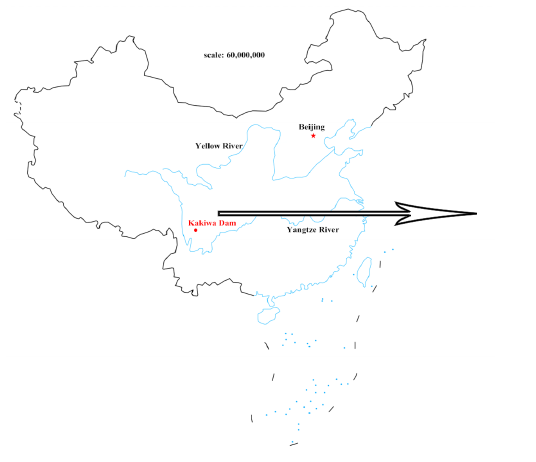
Figure 5. The max cross-section of the dam body. A total of 37 piezometers were installed for seepage monitoring of the dam body and dam foundation. Among them, the piezometer 𝑃 (cid:3005)(cid:3003)(cid:2879)(cid:2869)(cid:2871) is located downstream of the cur- tain. 𝑃 (cid:3005)(cid:3003)(cid:2879)(cid:2870)(cid:2872) − 𝑃 (cid:3005)(cid:3003)(cid:2879)(cid:2870)(cid:2875) are installed near the original ground line. Figure 5 presents the lo- cations and elevations of these piezometers. The water measuring weir is installed at the downstream cofferdam axis of the dam. The hydraulic conductivities of the five media, including the grout curtain, the top cover layer, the second cover layer, the moderately weathered zone, the slightly weath- ered zone, and the fresh bedrock zone, are limited to reasonable ranges and needed to be